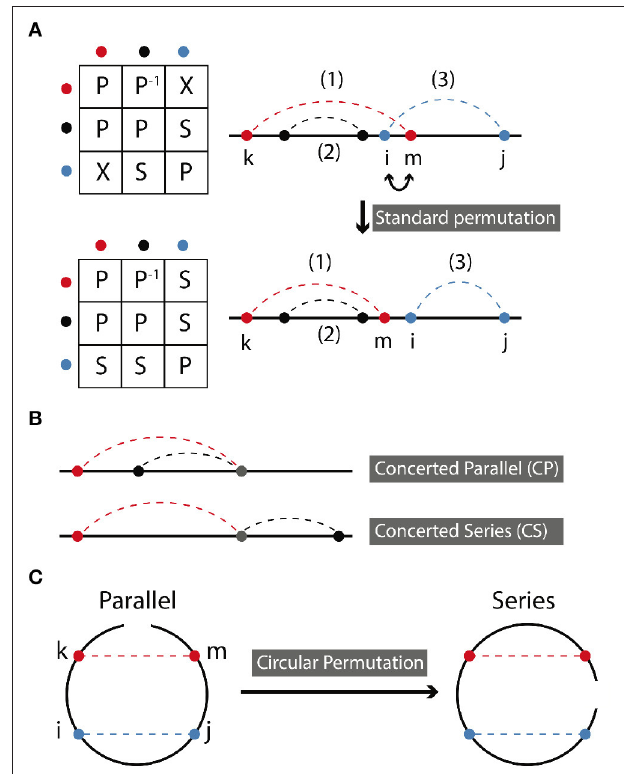
FIGURE 2 | (A) Standard permutation takes place when two nearest neighbor sites are exchanged. aP − 1 b , where a and b are abstract notations for bond a and bond b means that b is in parallel with a . Here, colors red, black, and blue, each stand for a specific bond. Relationships between bonds are represented by a letter, as described in the text. (B) Concerted parallel (CP) and concerted series (CS) are depicted. (C) Circular permutation occurs by rotating the endpoint of the molecule. It can transform a series relation to parallel and vice versa depending on the position of the ending